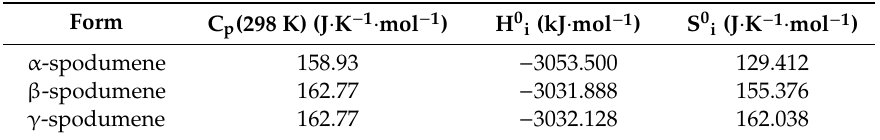
Table 3. Data of the di ff erent spodumene phases [40,41] (adapted with permission from Springer Nature, Contributions to Mineralogy and Petrology; published by Springer Nature,